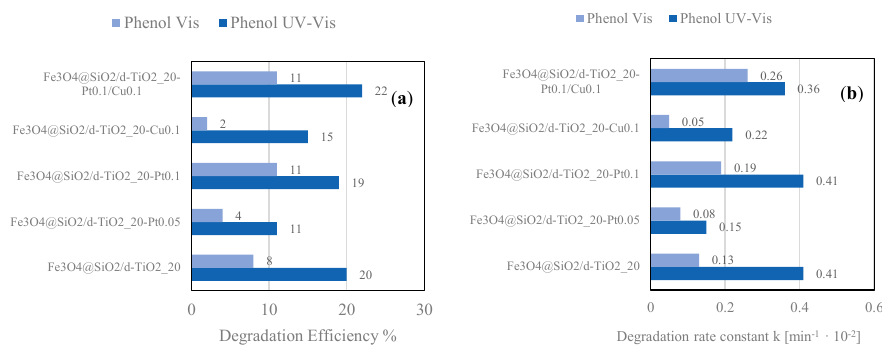
Figure 8. Efficiency of phenol degradation in UV-Vis and Vis light for magnetic Fe 3 O 4 @SiO 2 / d-TiO 2 -Pt / Cu photocatalysts, presented as % of degradation ( a ) and rate constant k ( b ). For the final stability and reusability test, the most active defective photocatalyst was selected. For sample d-TiO 2 _20/Pt0.1/Cu0.1, three 1-h-long subsequent cycles of phenol degradation under UV-Vis light were performed. The obtained results are presented in Figure 9.